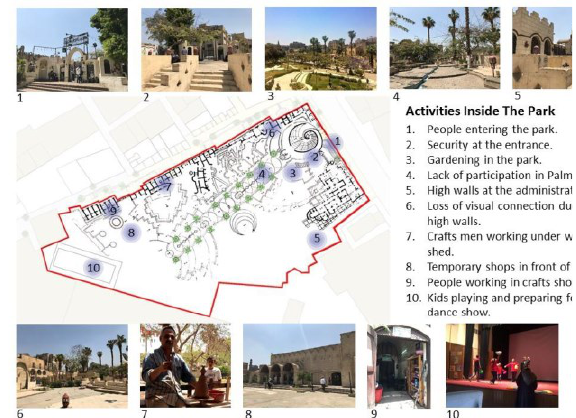
Figure 5 : Overview of Activities Inside the Park, BTU- Cottbus Double Msc Degree Students,